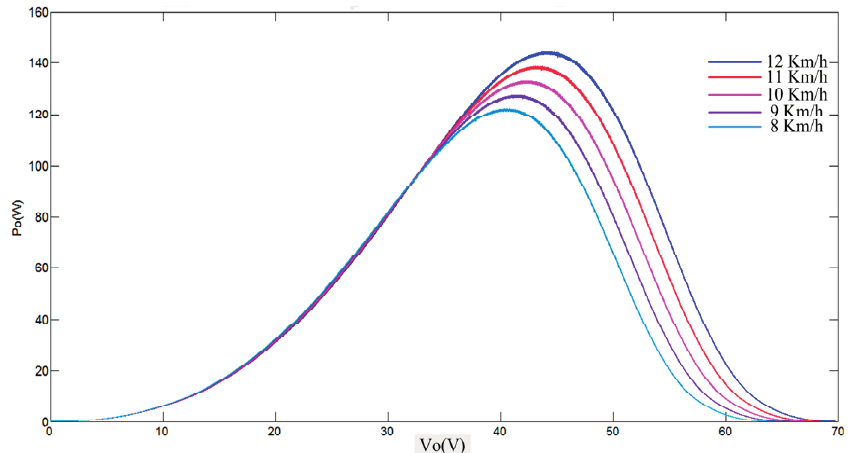
Figure 8. Simulated generator P-V characteristics curve.